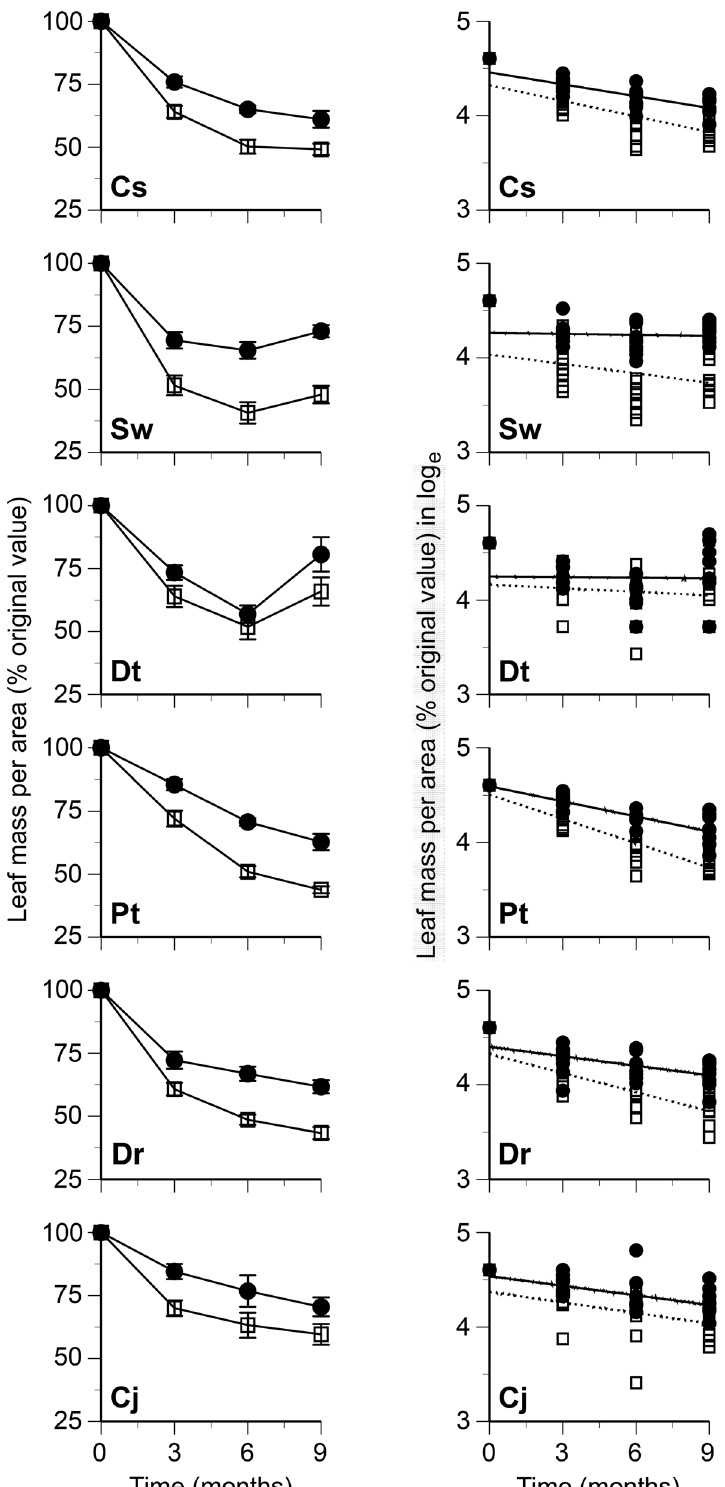
Figure 2. Changes in leaf mass per area (left) and relationship between time in months and remaining mass of leaf tissues (% original values of leaf mass per area) (right) in bleached (open square, dotted line) and nonbleached portions (filled circle, black line) during decomposition. Codes on the panels indicate the first letter of genus and species names of tree species. Bars indicate standard